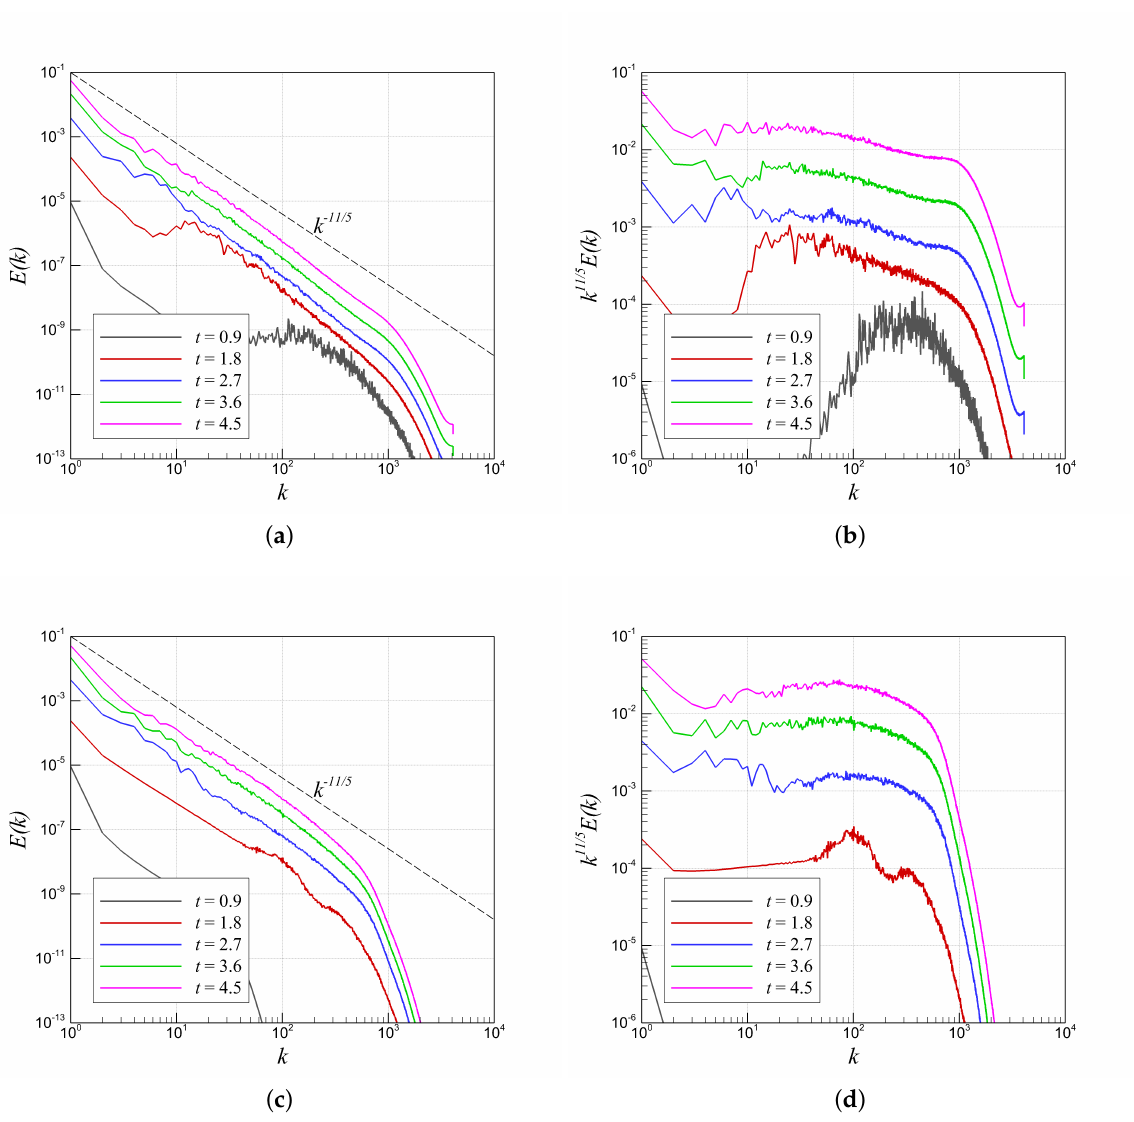
Figure 21. Time evolution of kinetic energy spectra and compensated kinetic energy spectra for the RTI problem with single-mode perturbation obtained using different modeling approaches at a resolution of 8192 × 24576; ( a ) kinetic energy spectra using ILES-Roe solver; ( b ) compensated kinetic energy spectra using ILES-Roe solver; ( c ) kinetic energy spectra using CS+RF ( σ = 1.0) solver; ( d ) compensated kinetic energy spectra using CS+RF ( σ = 1.0)